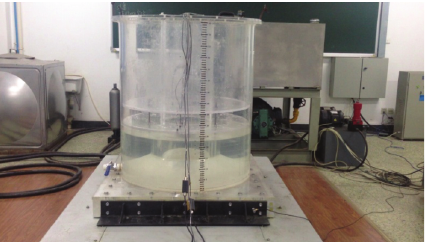
Figure 2: Experimental